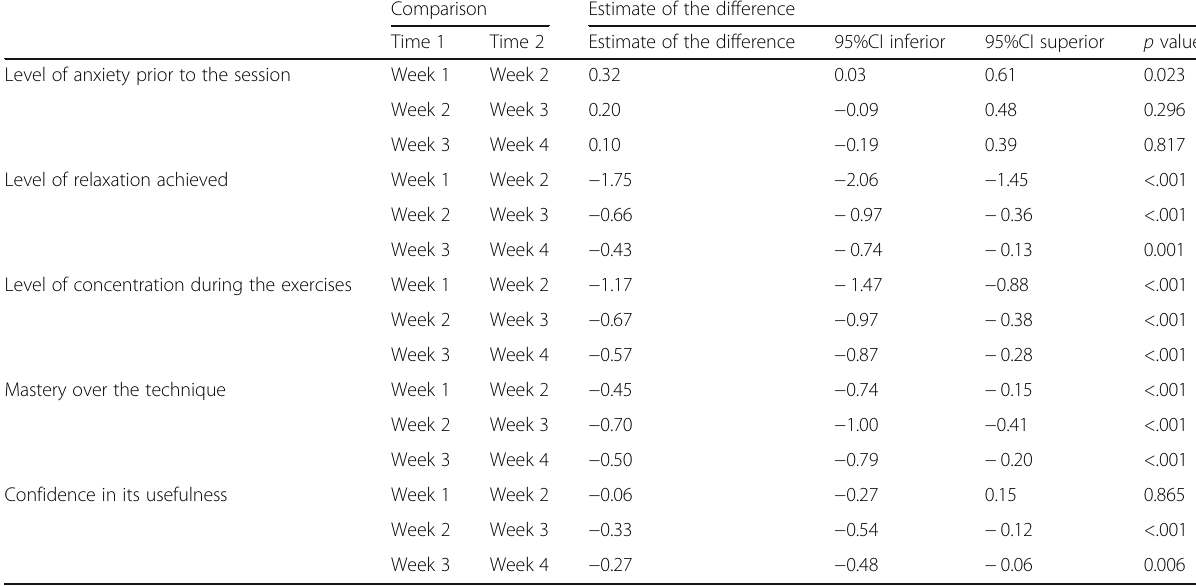
Table 3 Highlights the differences in estimation for the parameters evaluated for each two consecutive weeks